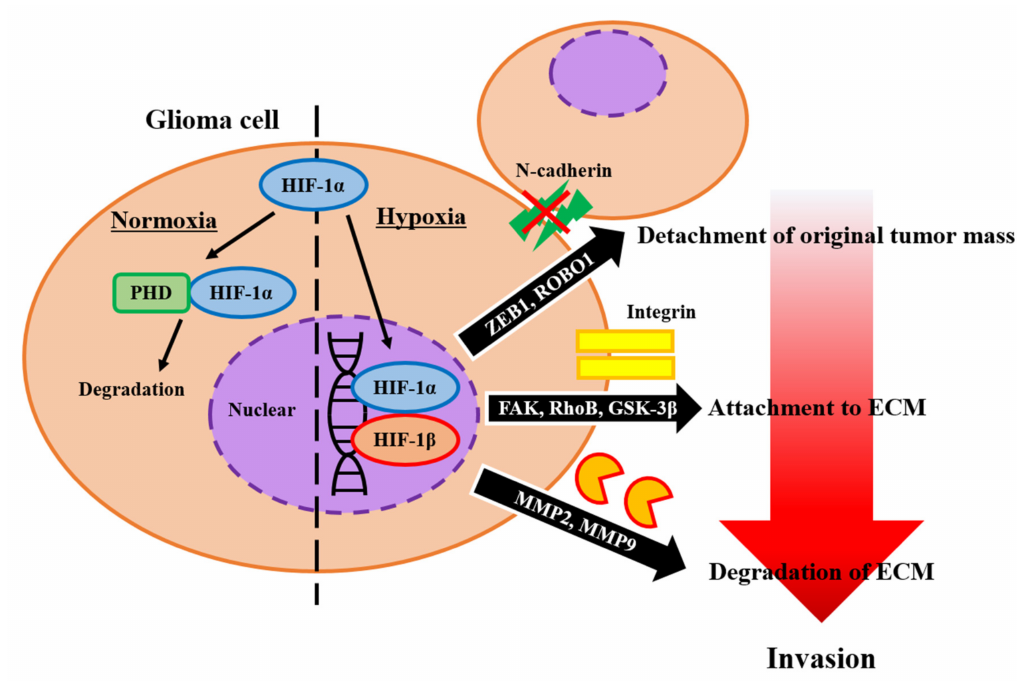
Figure 1. Schematic presentation of hypoxia-inducible factor-1 (HIF-1) function. In normoxia, prolyl hydroxylase (PHD) induced the degradation of HIF-1. In hypoxic conditions, HIF-1 contributes to several steps of glioma invasion. At first, HIF-1 detaches glioma cells from the original tumor mass by activating zinc finger E-box binding homeobox 1 (ZEB1) and roundabout guidance receptor 1 (ROBO1). In the next step, HIF-1 contributes to attachment to the surrounding extracellular matrix (ECM) by focal adhesion kinase (FAK), Ras homolog family member B (RhoB), and glycogen synthase kinase 3 β (GSK-3 β ). Finally, HIF-1 activates matrix metalloproteinases (MMPs) and degrades